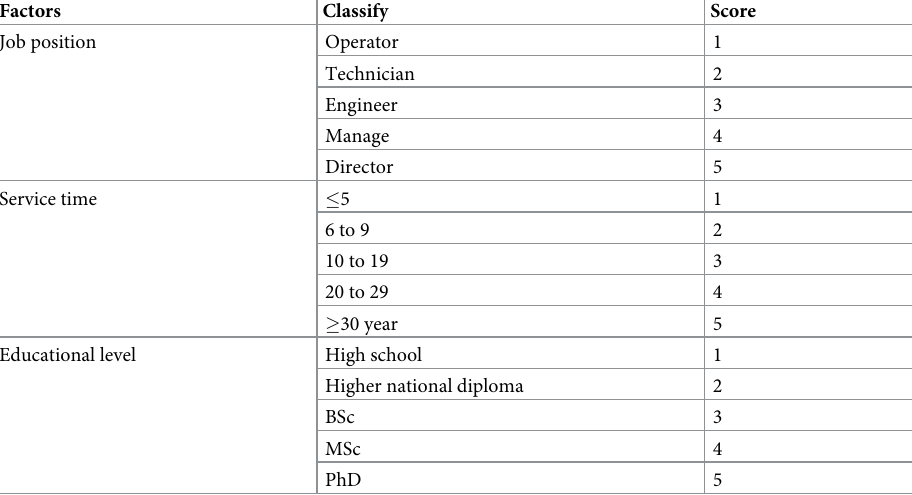
Table 3. Score rating of different